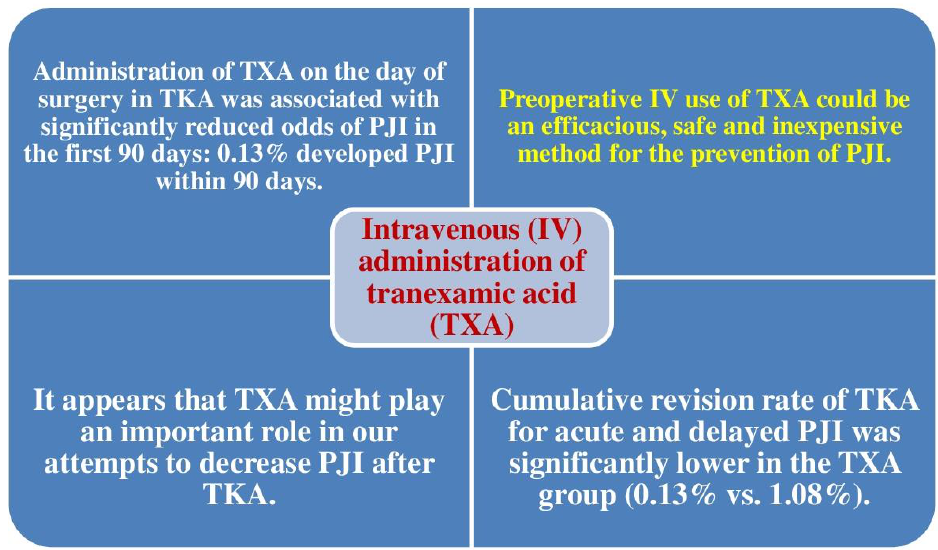
Figure 3. Intravenous administration of tranexamic acid appears to play an important role in the prevention of periprosthetic joint infection (PJI) after primary total knee arthroplasty (TKA) [35,36].